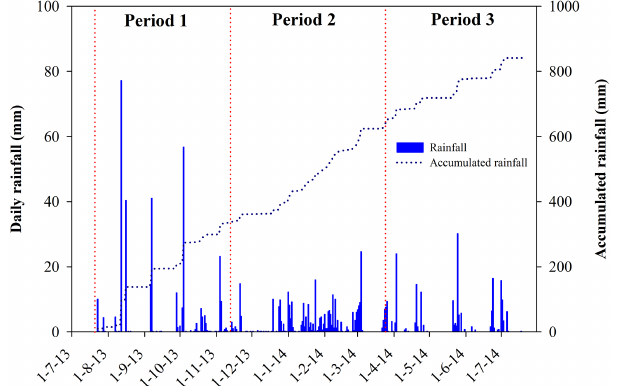
Figure 4. Daily rainfall and accumulated rainfall during the survey period (July 2013–July